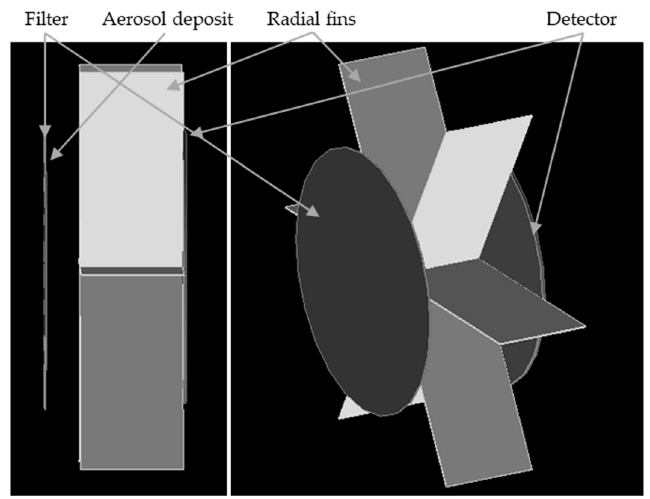
Figure 6. Representation of the sampling and detection zones, as defined in Geant4 and based on a Mirion ABPM203M.